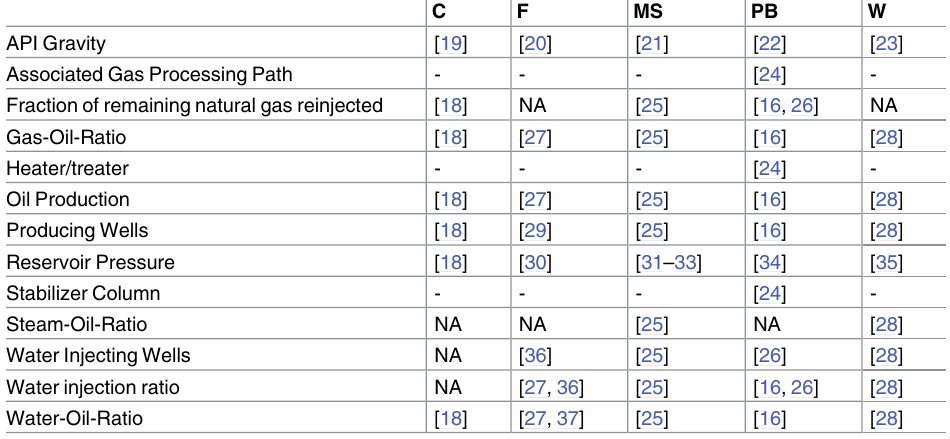
Table 5. Abbreviated data sources (C = Cantarell, F = Forties, MS = Midway-Sunset, PB = Prudhoe Bay, W =